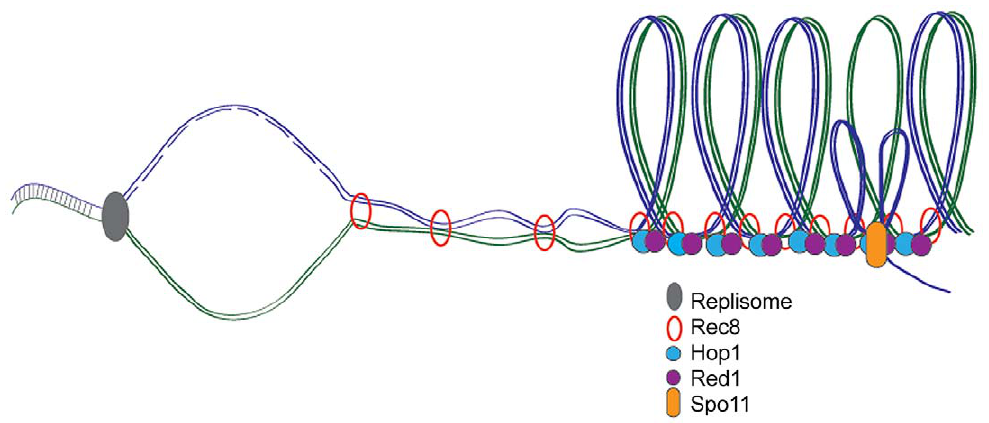
Figure 1. Meiotic DNA replication, chromosome axes, and DSB formation. During meiosis, DNA is replicated and meiosis-specific cohesin Rec8 holds sister chromatids together while axis proteins Red1 and Hop1 associate to form the loop axis structure. Endonuclease Spo11 creates DSBs required for homologous recombination and crossover formation at the axis where single-stranded DNA is exposed to facilitate homology search.